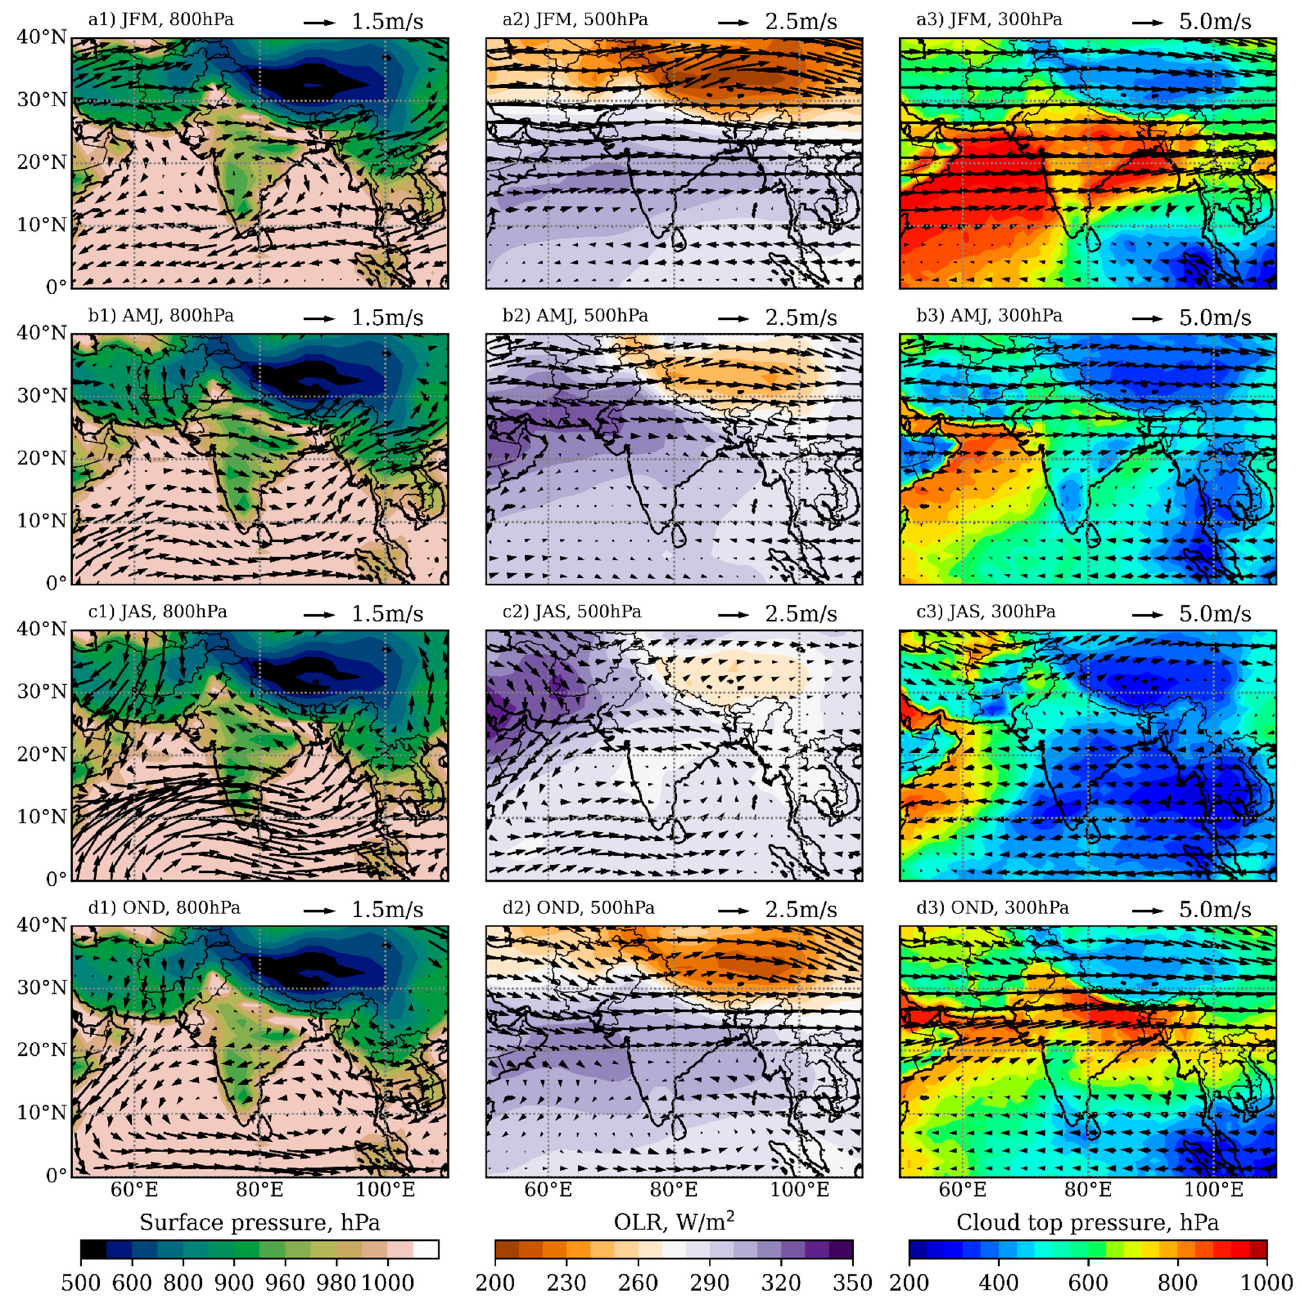
Figure 3. Wind vectors for the JFM (panels a1 – a3 ), AMJ ( b1 – b3 ), JAS ( c1 – c3 ), and OND ( d1 – d3 ) months of 2010 from